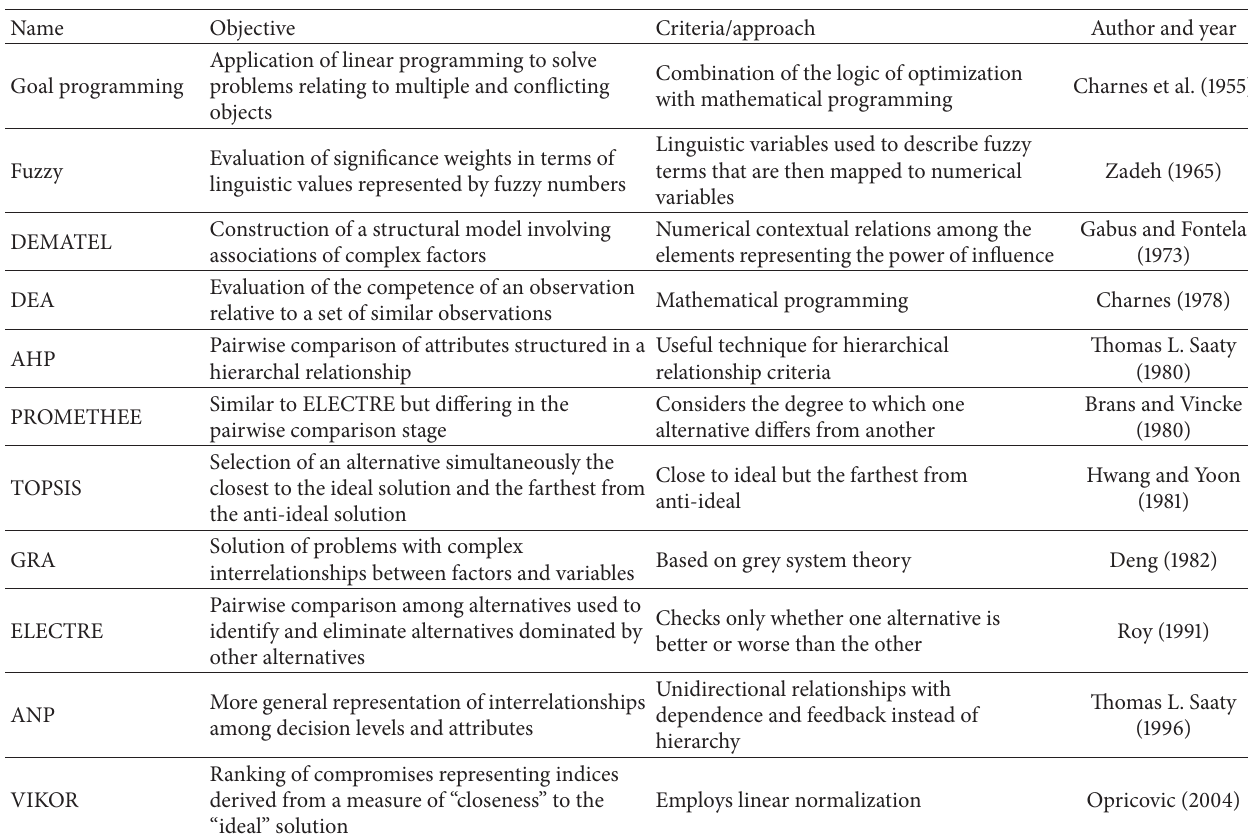
Table 1: Summary of MCDA techniques and